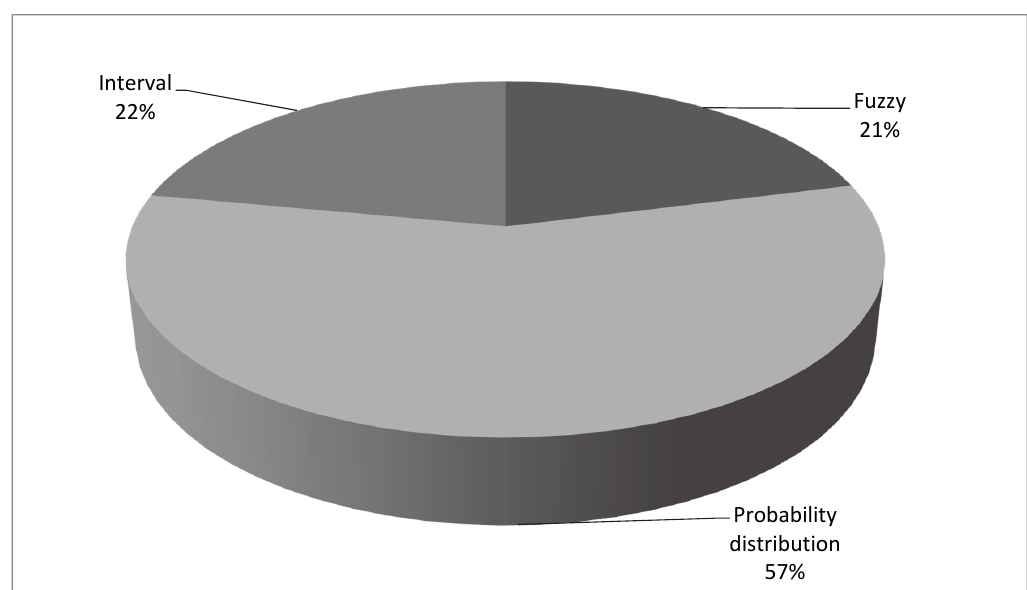
Fig. 2. Distribution of methods for modeling uncertain